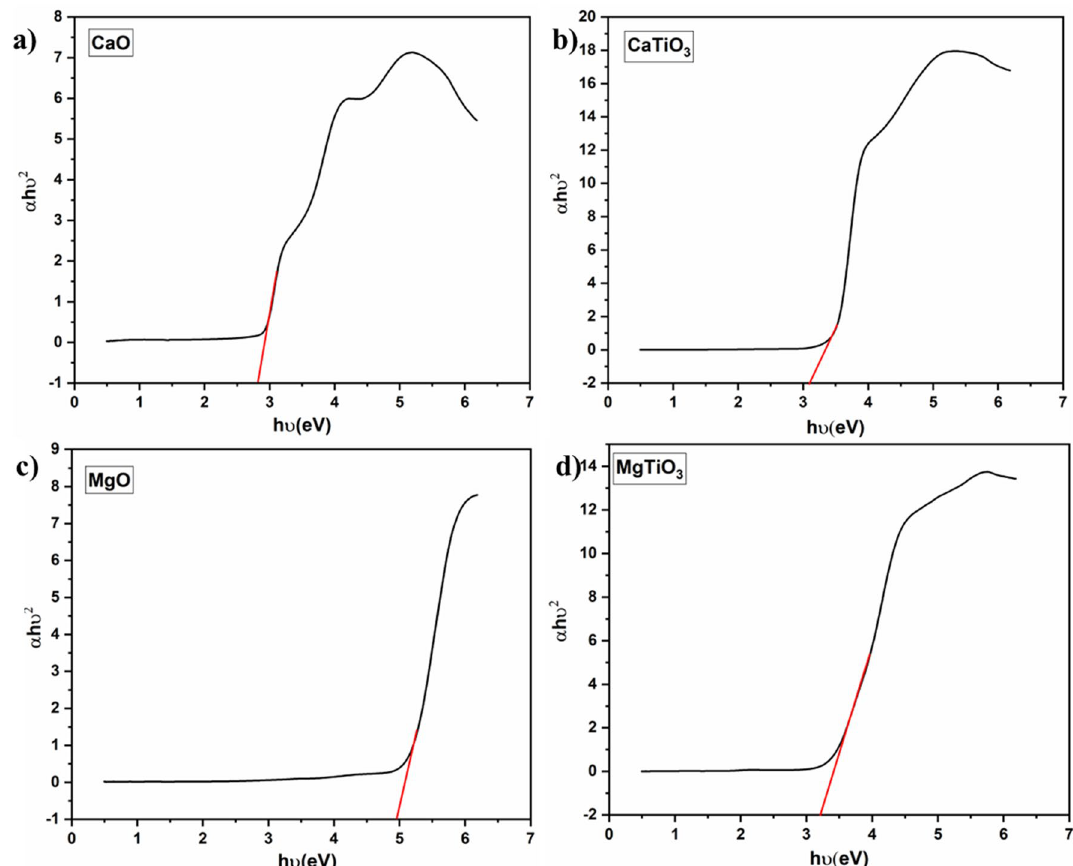
Figure 4. Tauc’s Plots for bandgap estimation of ( a ) CaO, ( b ) CaTiO 3 , ( c ) MgO and ( d ) MgTiO 3